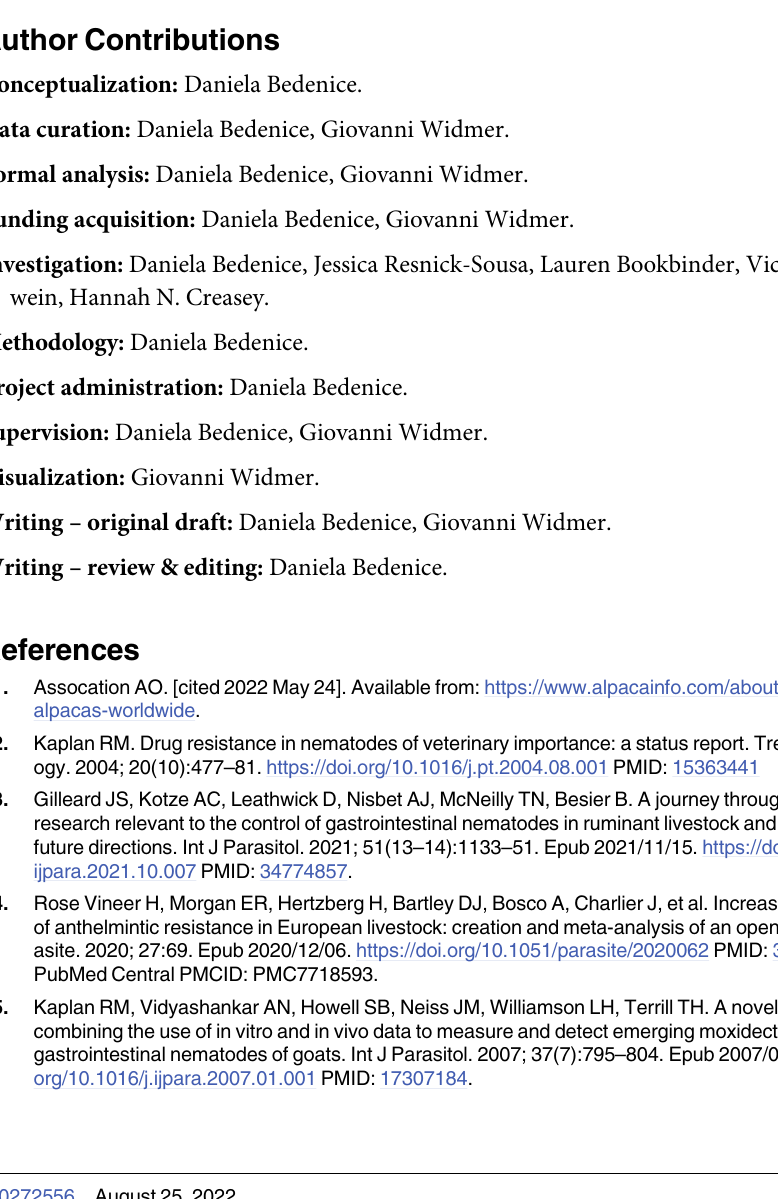
S2 Table. Taxonomy by alpaca and by timepoint. S3 Table. LDA analysis of timepoint 2 samples grouped according to consistent shedder status. S4 Table. Ten most abundant OTUs, fecal egg count, by timepoint and alpaca including timepoint 1 age and